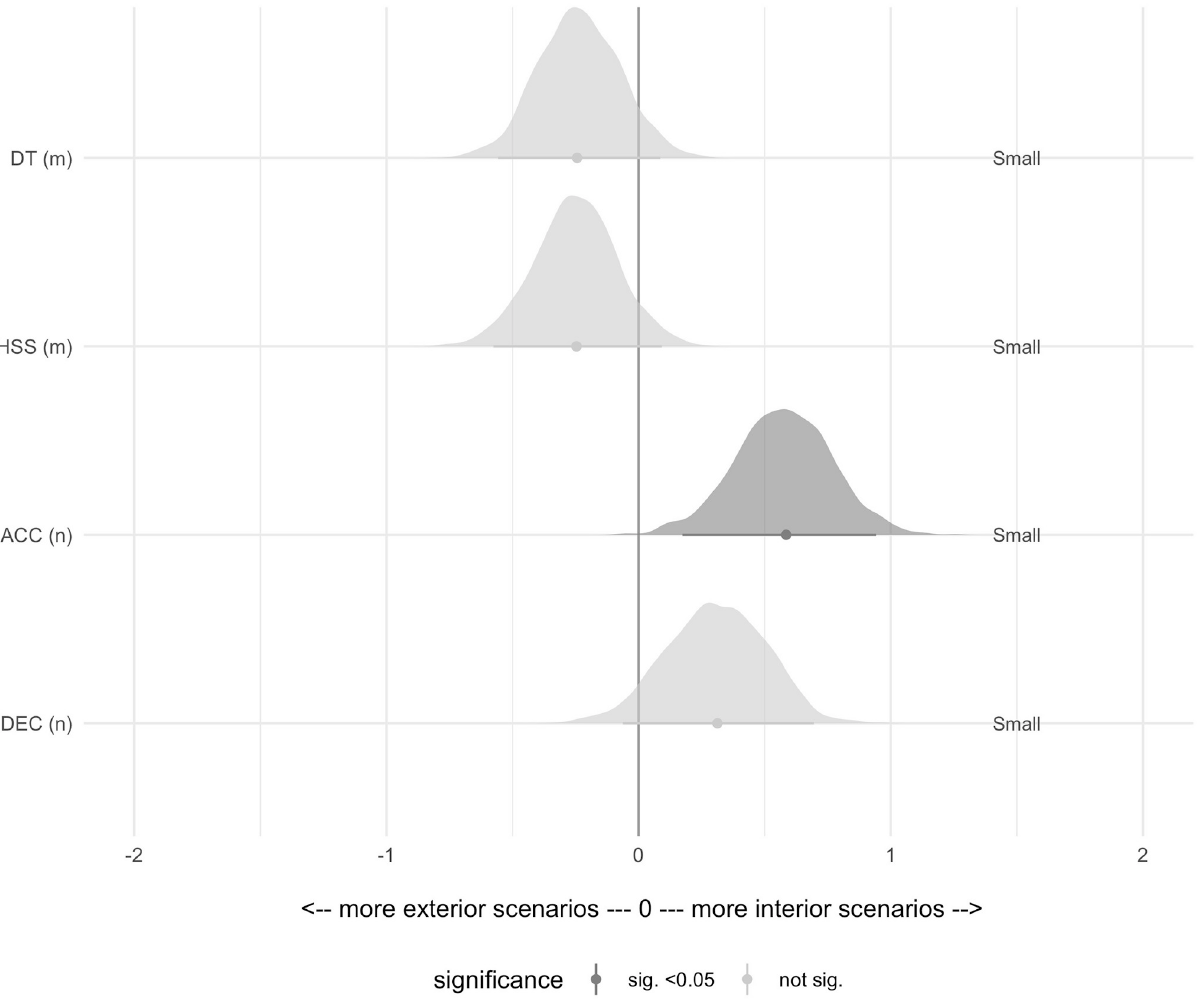
Fig 2. Pairwise Cohen’s d differences in the most demanding scenarios (time epoch 30 s) of a match by playing position for each variable. The significant different variables (high-intensity accelerations) are shown in dark grey, and the non-significant (distance travelled, high speed-skating and high-intensity decelerations) in light grey. Abbreviations—ACC: high-intensity accelerations; DEC: high-intensity decelerations; DT: distance travelled; HSS: high-speed skating; MDS: most demanding scenarios.